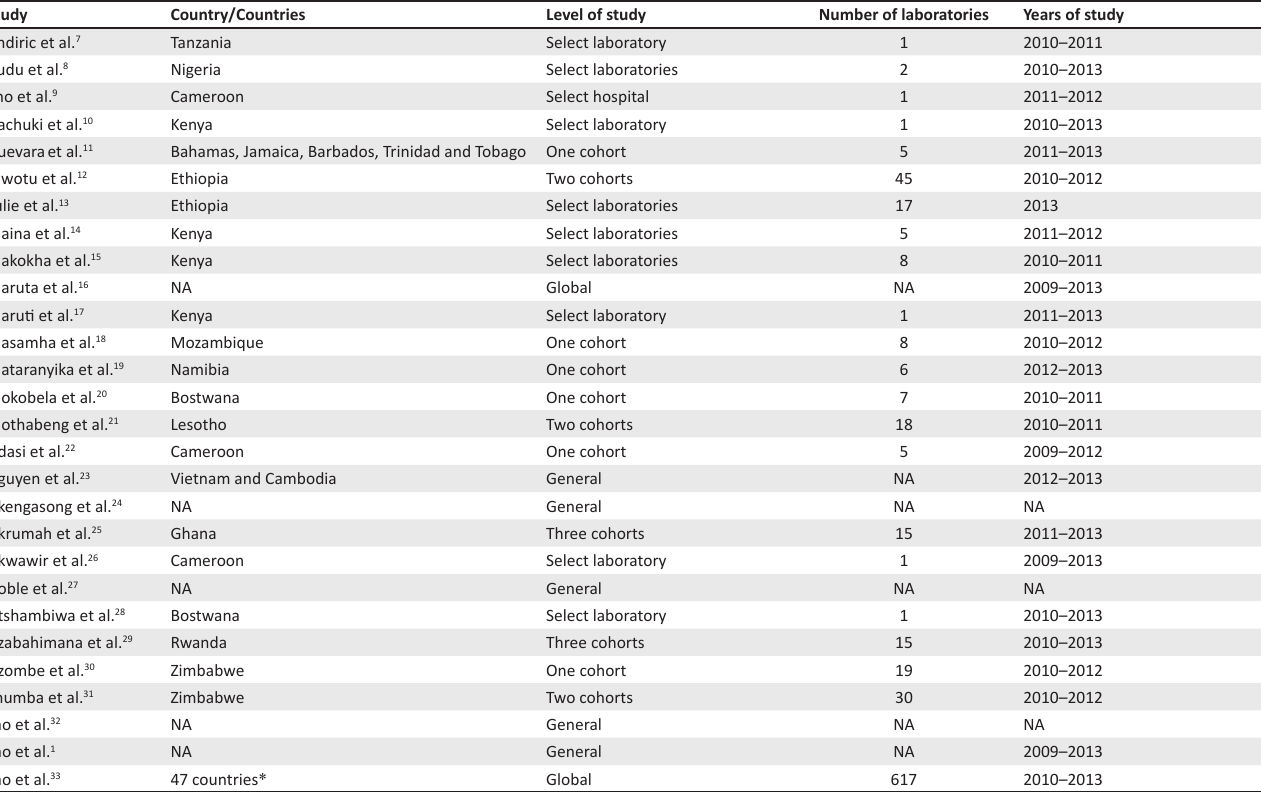
TABLE 1: Characteristics of published SLMTA